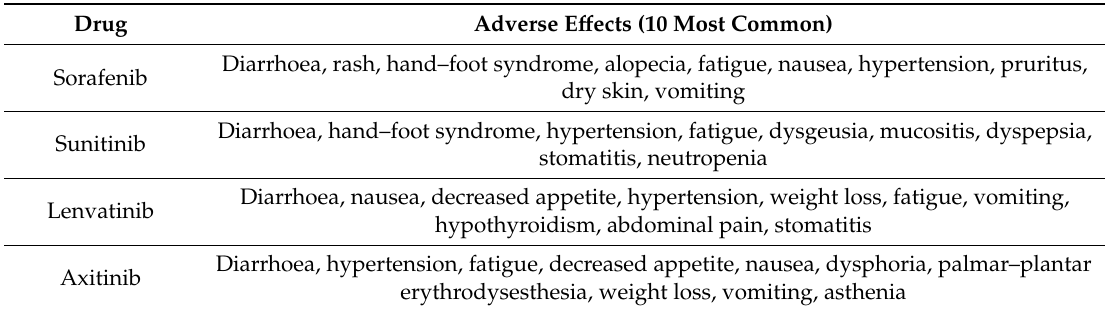
Table 4. Adverse e ff ects of the multikinase inhibitors sunitinib, sorafenib, lenvatinib and axitinib